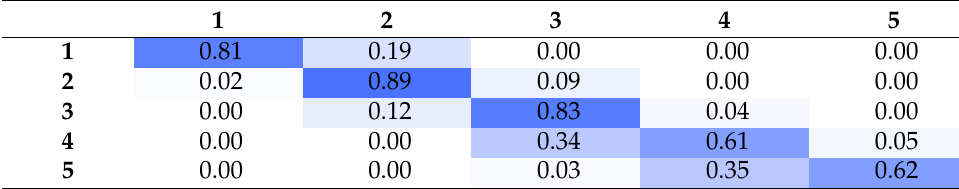
Table 9. Transition probability matrix: price to price.